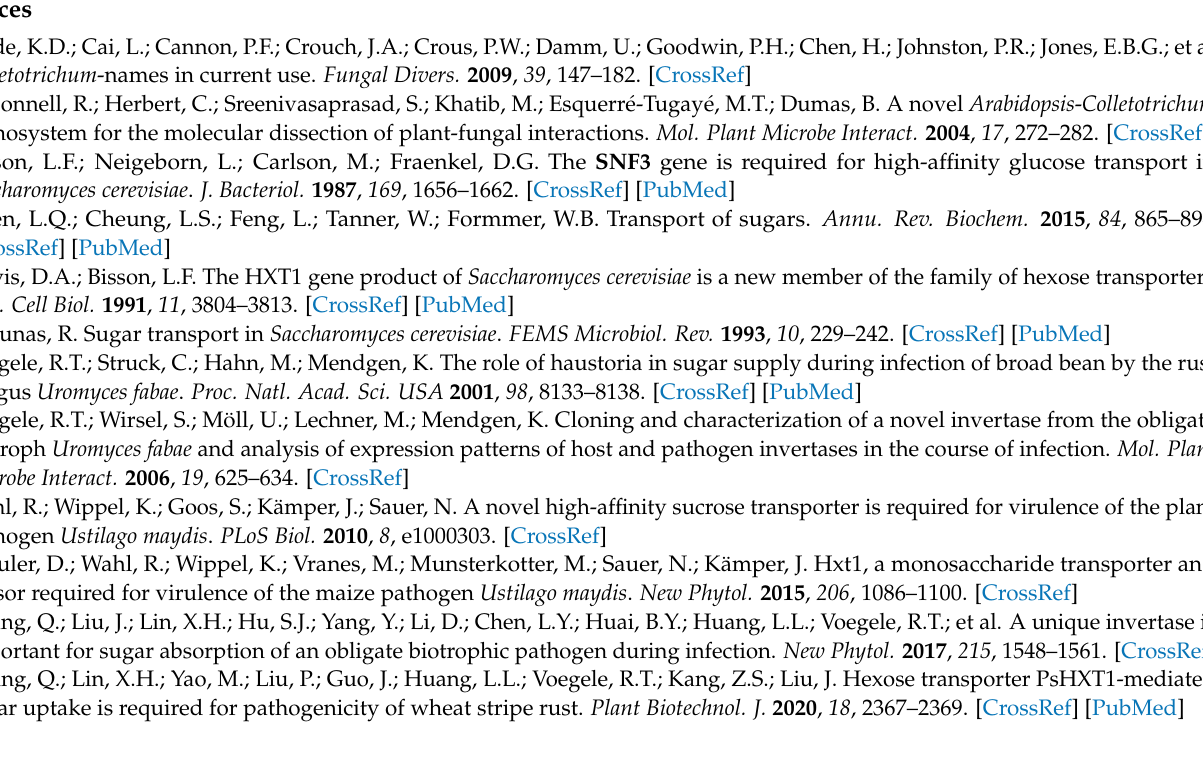
genes. Figure S2: Multi-alignment of ChHxt1p to ChHxt6p. The amino acid sequences of ChHxt1p